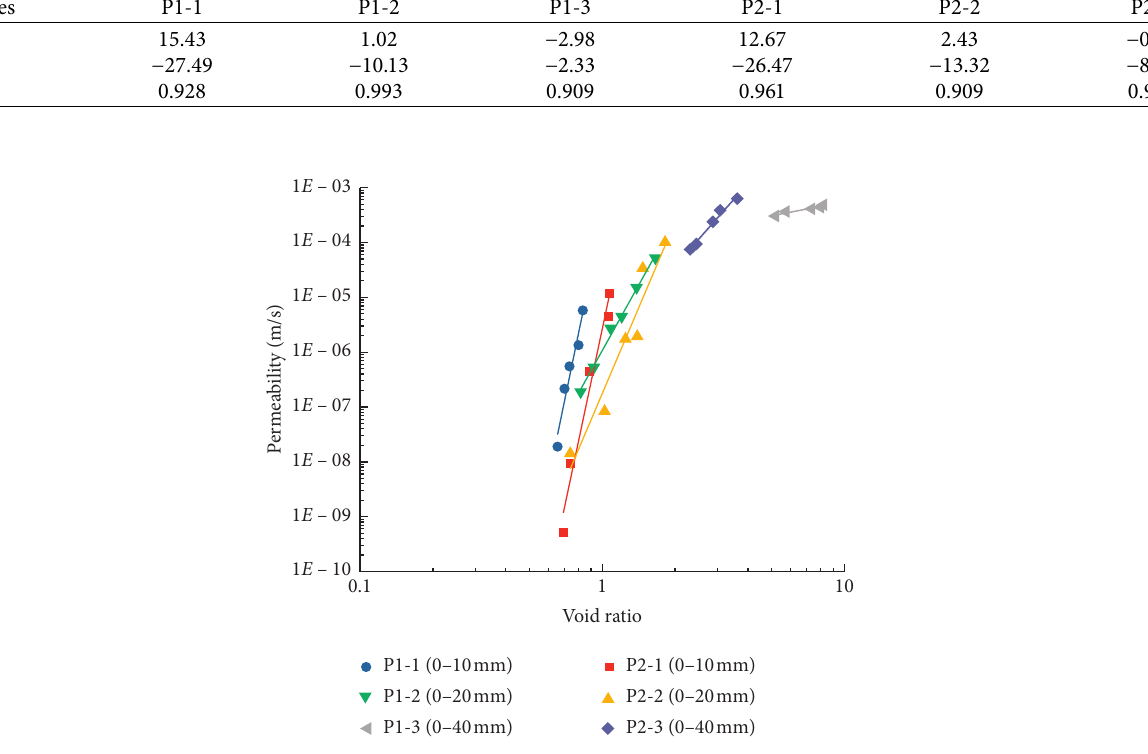
Figure 8: Relationship between the permeability and the void ratio of samples with different particle sizes. Table 5: Values of coefficients E and F and correlation coefficient R 2 .